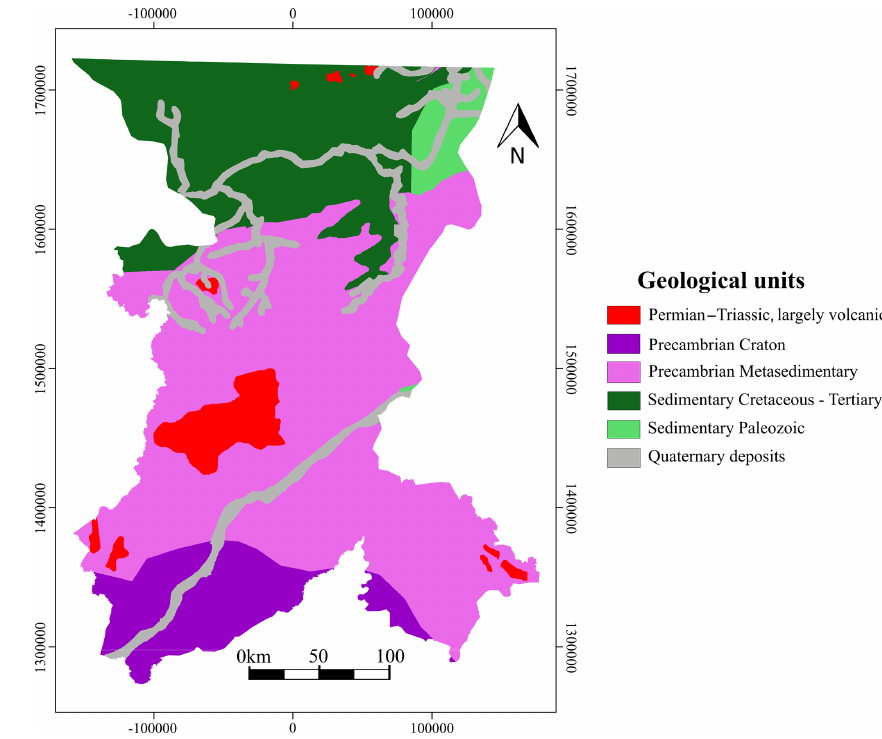
Figure 3. Geological map showing the main units with outcrops in the study area (adapted from BGS, 2021).